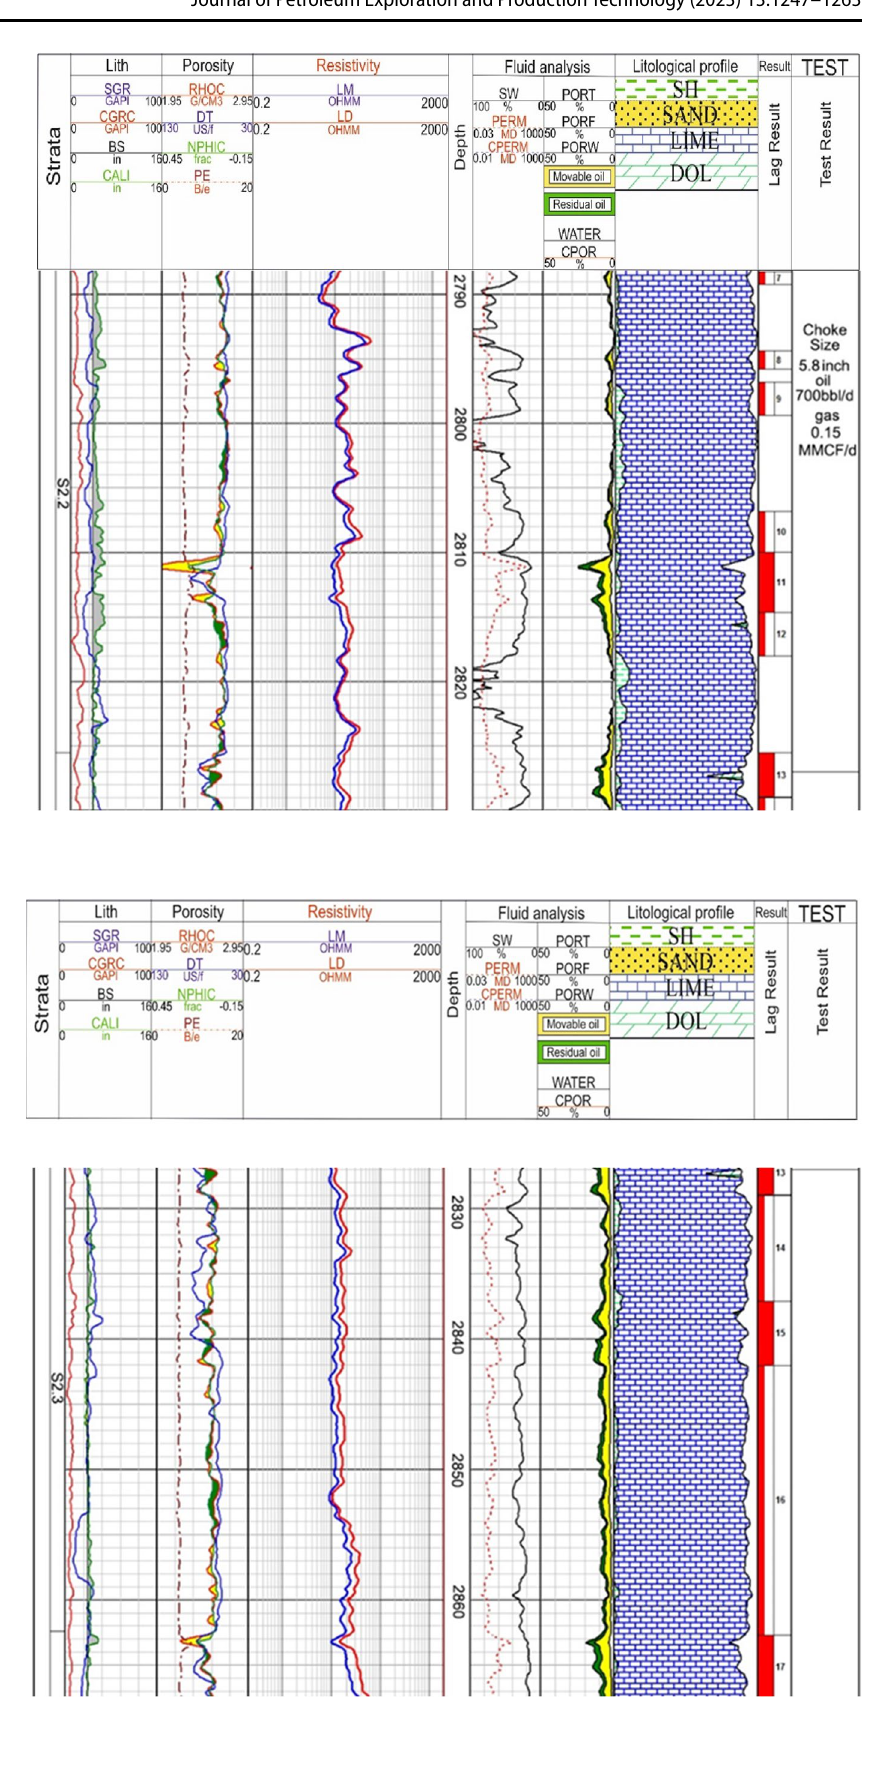
Fig. 14 Composite well log for production zones within depth interval 2790–2825 m